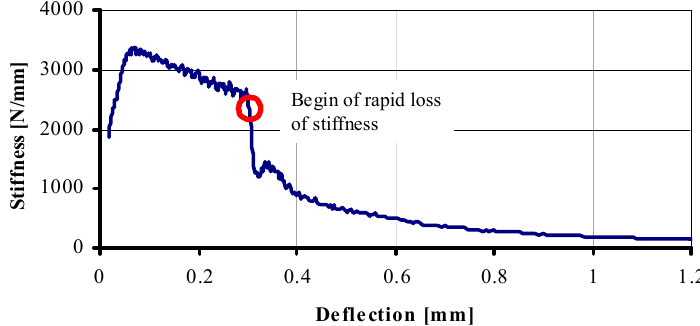
Figure 13: Specimen stiffness for point support type